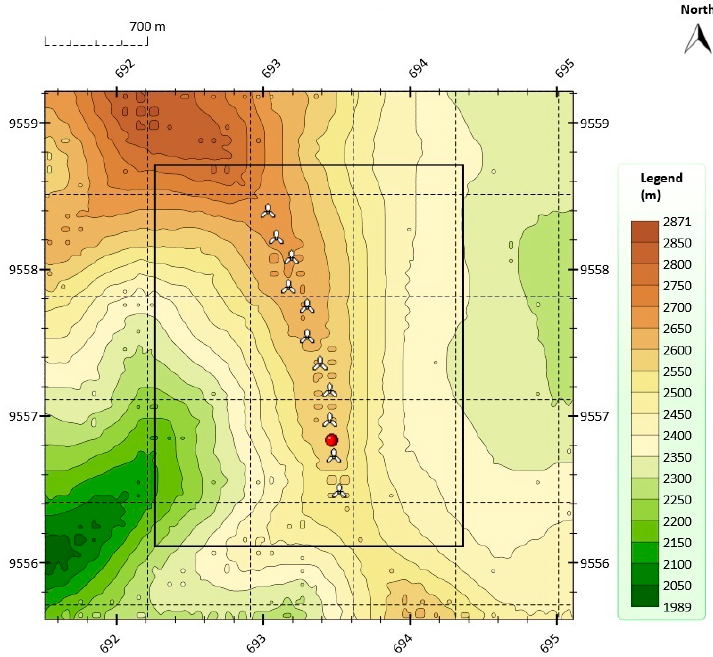
Figure 1. Orographic map of the VWF with wind turbine positions in UTM (Universal Transverse Mercator) coordinates.